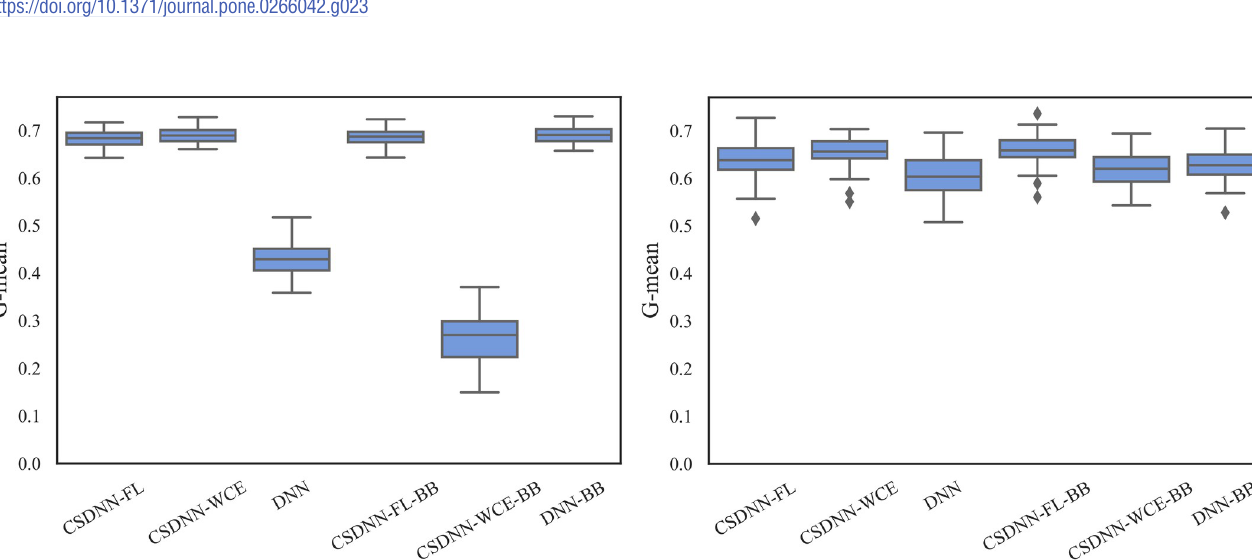
Fig 24. Comparison of CSDNN-FL and CSDNN-WCE versus DNN (in terms of G-mean) on the MOMI Full and African American populations. Each boxplot denotes variability of the G-mean (vertical axis) for different methods.